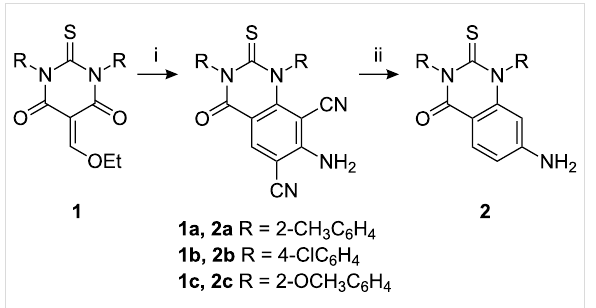
Scheme 1: Synthesis of 2 , reagents and conditions: (i) CH 2 (CN) 2 , NH